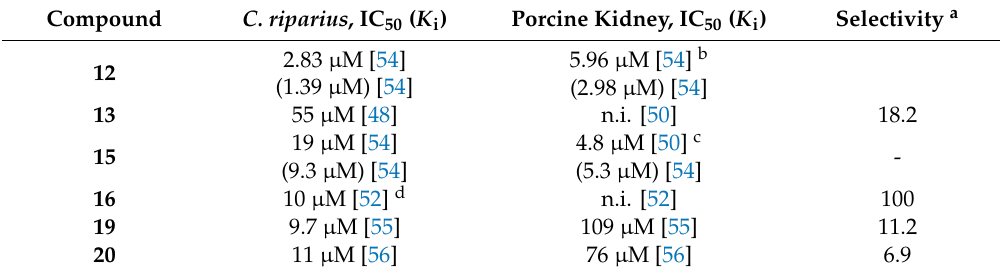
Table 2. Inhibition of C. Riparius and porcine kidney trehalases by compounds 12 , 13 , 15 , 16 , 19 , and 20